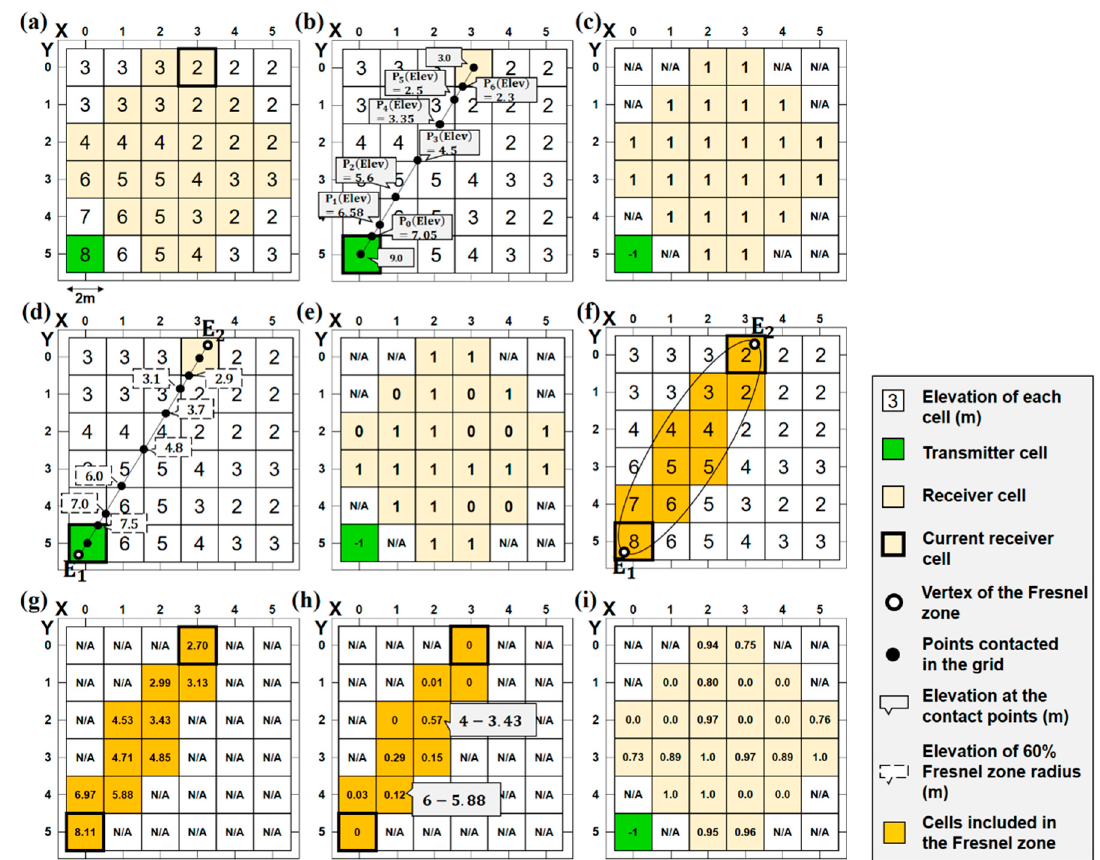
Figure 4. An example of calculating index maps for all cells when the transmitter offset and the receiver offset is 1 m and the wavelength of the signal is also 1 m. ( a ) Identifying the current transmitter cell and the current receiver cell; ( b ) extracting all contact points on the LOS connecting the current transmitter cell and receiver cell; ( c ) visibility index map; ( d ) extracting all contact points on the LOS connecting two vertexes of the Fresnel zone; ( e ) 2D Fresnel index map; ( f ) extracting all cells included in the 3D Fresnel zone; ( g ) elevation raster for the lower surface of the 3D Fresnel zone; ( h ) differences of elevation between extracted cells and the lower surface of the 3D Fresnel zone; and ( i ) 3D CVR index map.